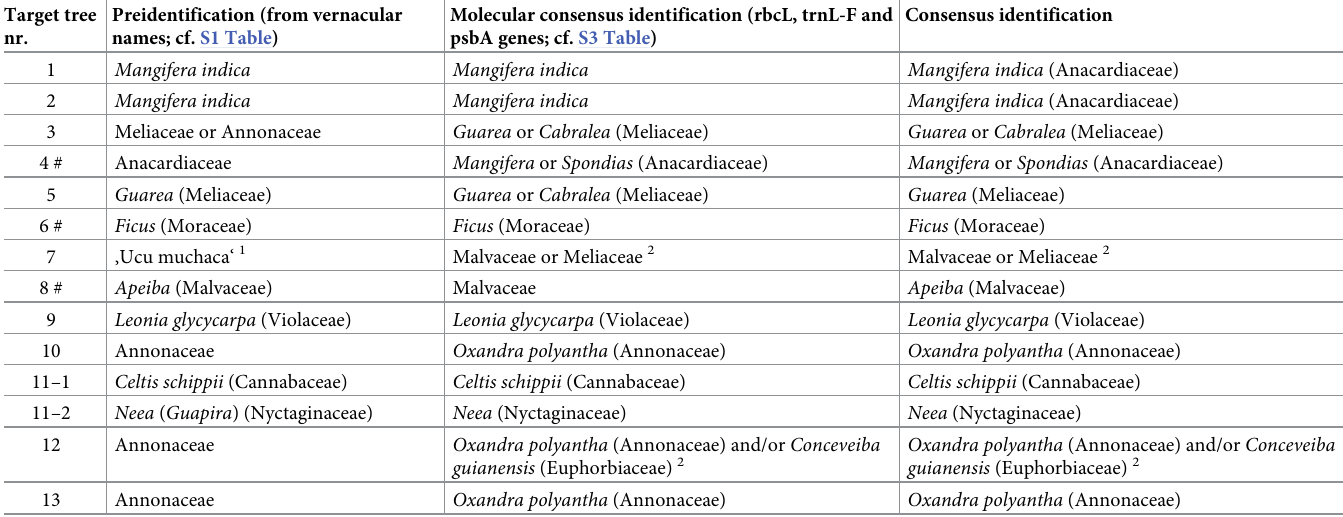
Table 3. Identification of target trees, results from blasting on NCBI (BLAST matches usually > 99%). Target tree